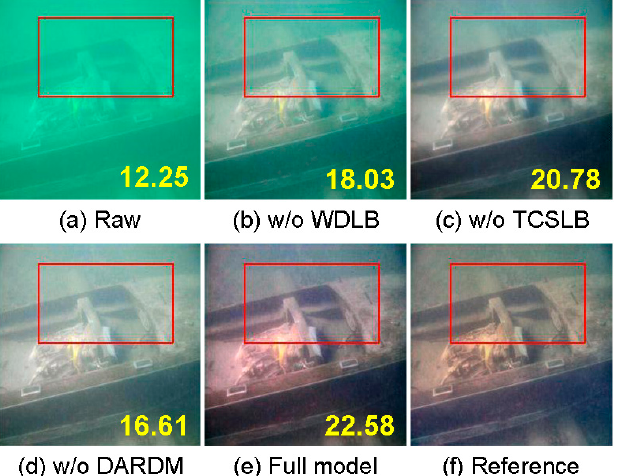
Figure 14. Ablation study of the performance of the model components. The number on each image represents its PSNR score. Table 4. Quantitative comparison results of the ablation study of the components of DBFNet in terms of PSNR (dB), SSIM, and MSE ( × 3 10 ) values. Bold values indicate the best results.